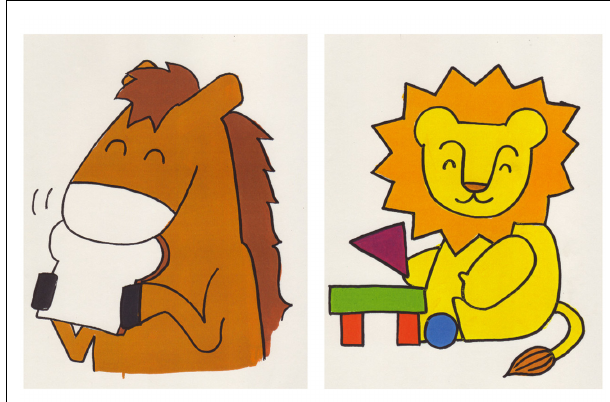
FIGURE 1 | Examples of pictures